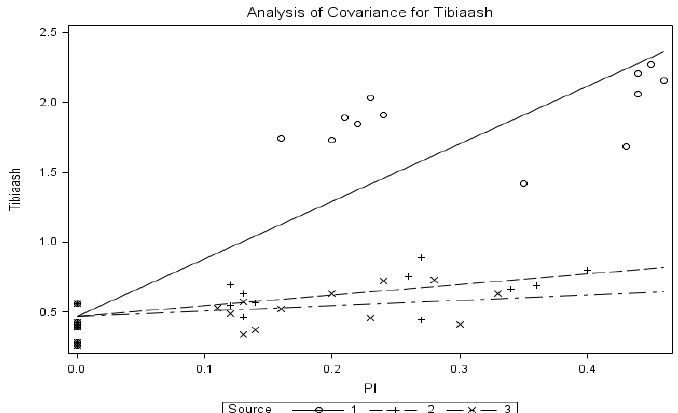
Figure 4. Common-intercept, multiple-linear regression of absolute amount of tibia ash (tibiaash; g) on supplemental P intake of chicks fed diets supplemented with P from monosodium phosphate (MSP; Source 1), brown-seeded pea (BP; Source 2), and Yellow-seeded pea (YP; Source 3). The circular marker represents MSP, the plus marker represents BP, and the multiplication marker represents YB. The common-intercept, multiple-linear regression equation (mean±standard error) was Y = 0.468±0.052+4.127±0.253MSP+0.757±0.347BP+ 0.381±0.406YP, R2 = 0.86, p<0.0001; the relative bioavailabilities estimated by slope-ratio were 18.0% and 9.23% for BP and YP, respectively.